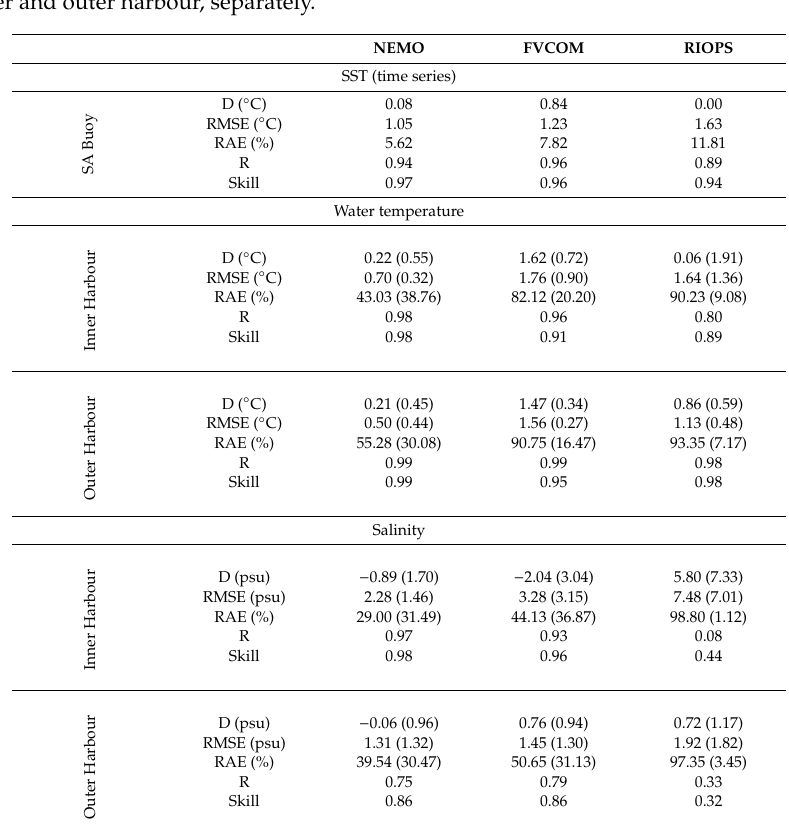
Table 4. Evaluation metrics for the time series of the SST (compared to the observations from the SmartAtlantic (SA) Buoy), and the water temperature and salinity (compared to the observed CTD profiles). See the definitions of the metrics in Equations (5)–(9) and in the text. The mean bias (D), RMSE and RAE are averaged for the stations in the inner and outer SJH. Numbers in brackets are the standard deviations across the stations. Correlation and skill were computed using all the profile data in the inner and outer harbour,